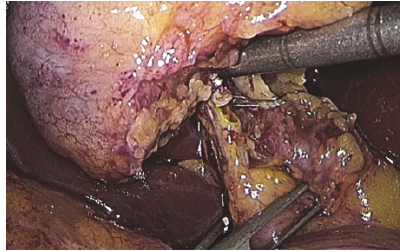
Figure 4: Gentle squeeze on the CBD and the cystic duct.